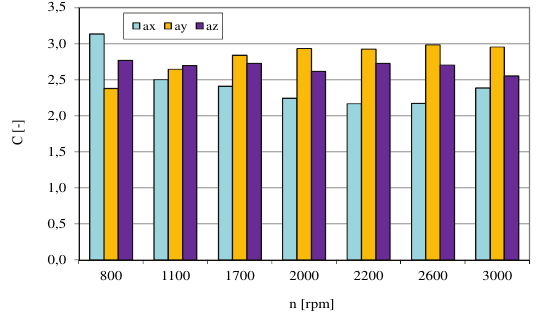
Fig. 8. Peak coefficient of vibration accelerations for X, Y and Z dimen- sions and different engine speeds